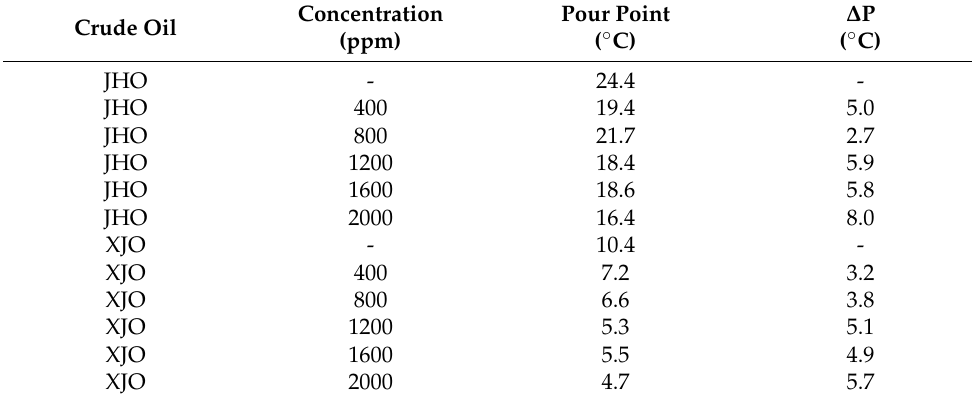
Table 3. Influence of CA R H on the pour point of crude oil.